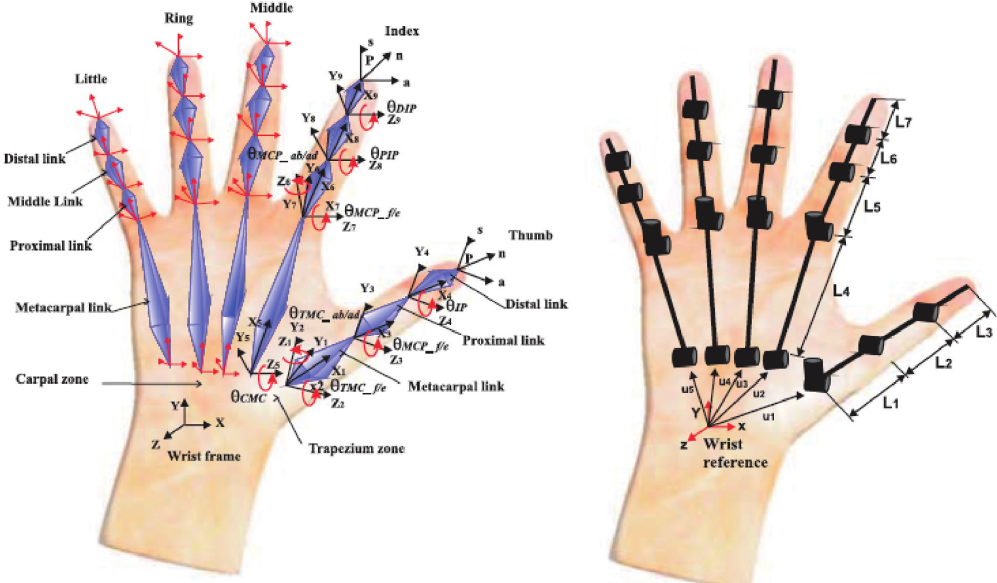
Figure 1: Kinematic configuration of the human